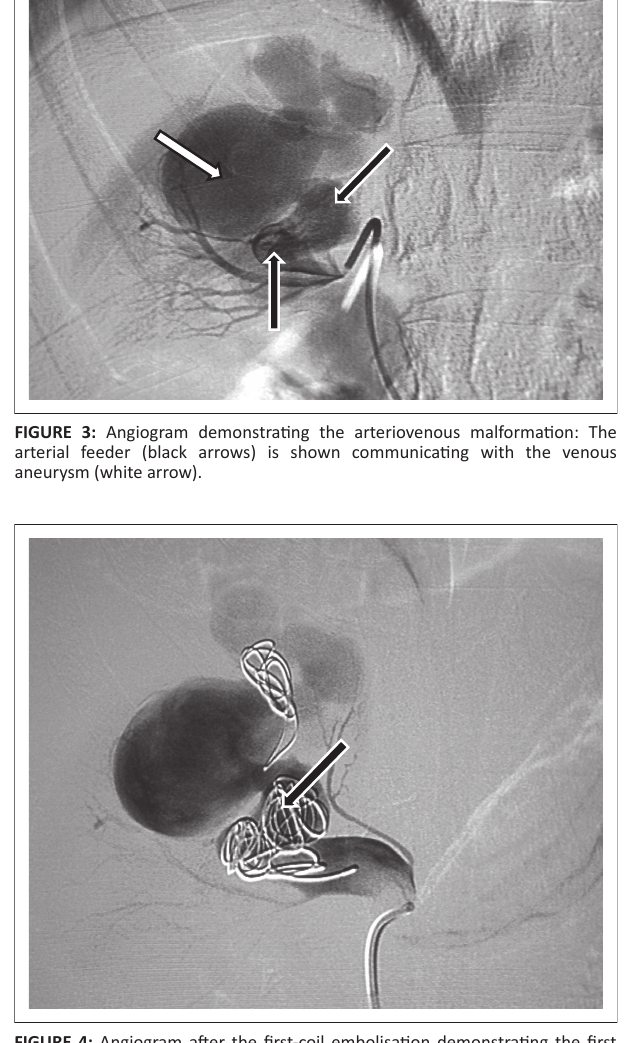
FIG URE 4: Angiogram after the first-coil embolisation demonstrating the first micro coil that migrated to the venous side because of high flow. The ectatic segment of the feeding artery was packed with coils but despite that there was still filling of the arteriovenous malformation because of high flow.